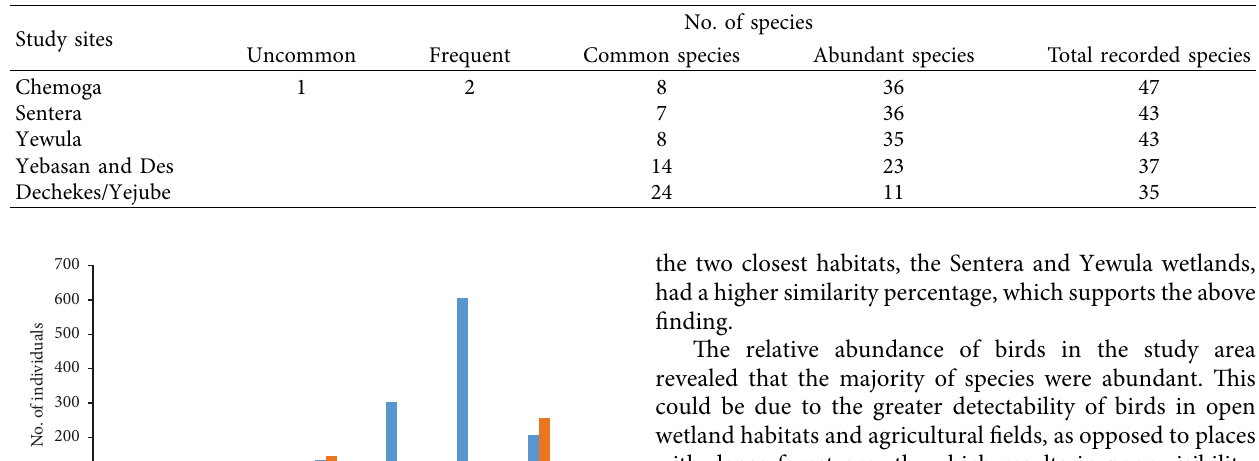
Table 2: Abundance rank of bird species along the study sites.